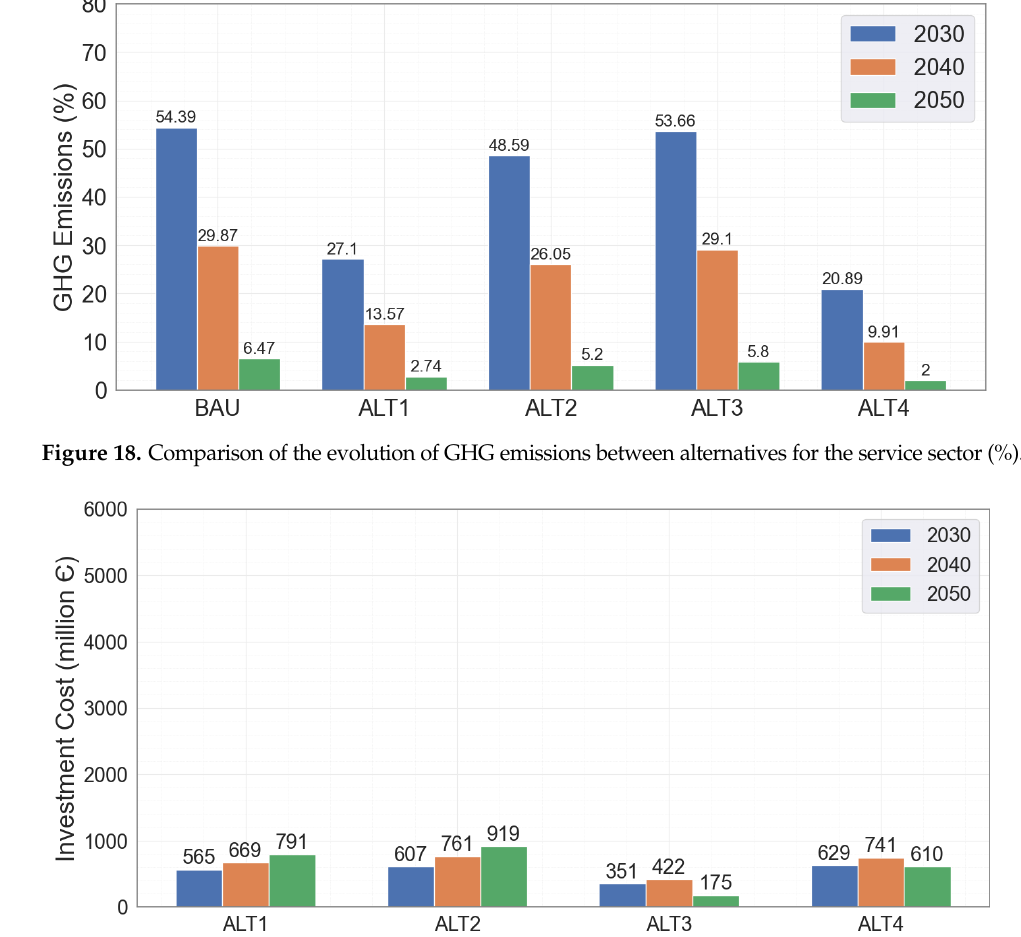
Figure 19. Comparison of the evolution of investment cost between alternatives for the service sector (million €